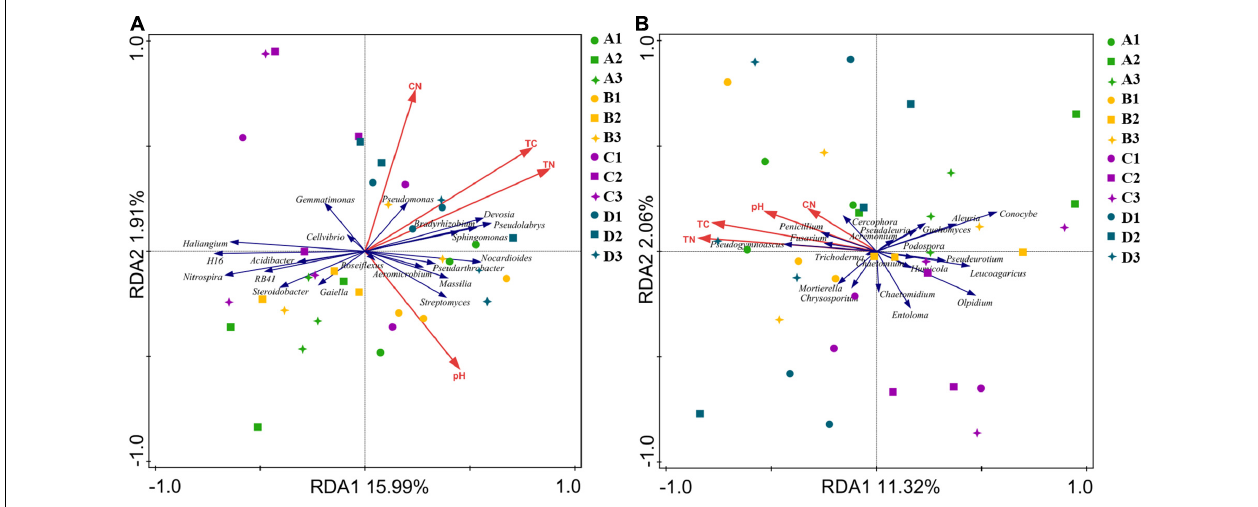
FIGURE 5 | Redundancy analysis biplots of soil bacterial (A) and fungal (B) community composition. Soil properties included soil total carbon (TC), total nitrogen (TN), soil pH, and carbon/nitrogen ratio (C/N). A, non-treated; B, fenaminosulf; C, kasugamycin; D, dazomet. Numbers 1, 2, and 3 represent samples collected at 14, 55, and 110 days after soil treatment,